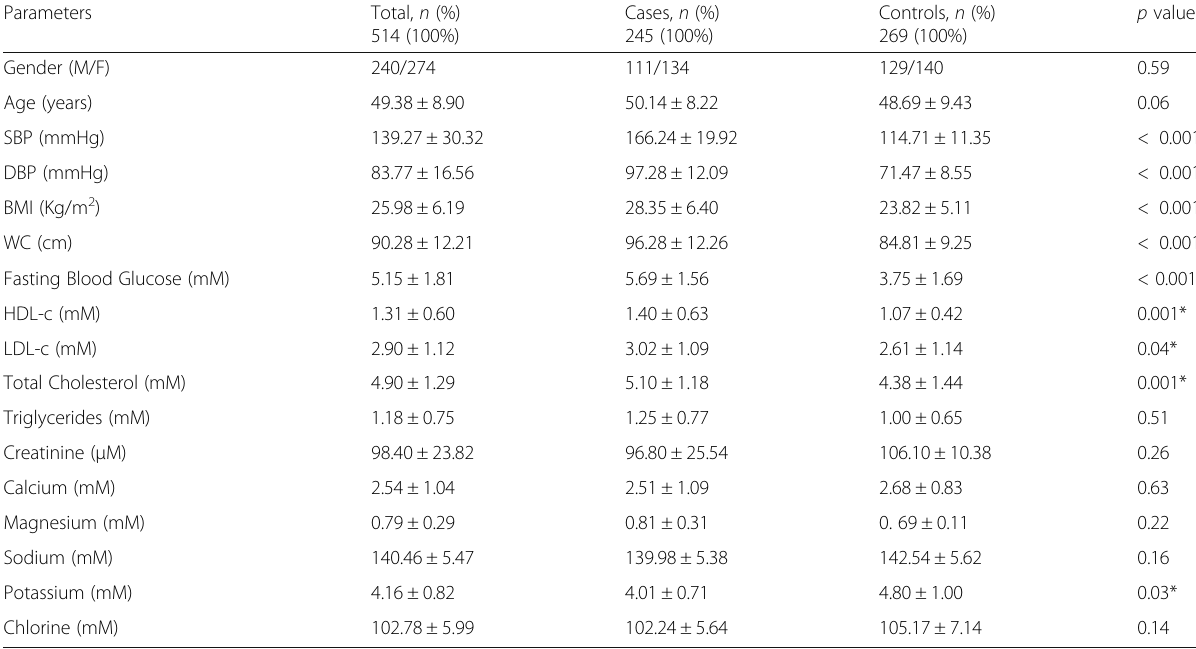
Table 1 General Characteristics of the study